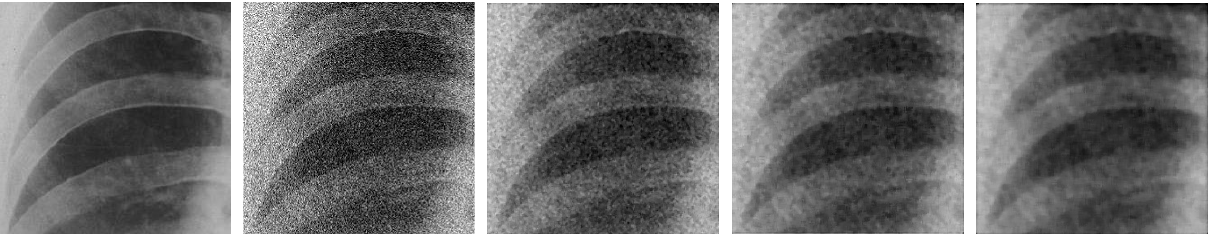
Fig. 1 Comparison of the salt and pepper noise in filtering images by median